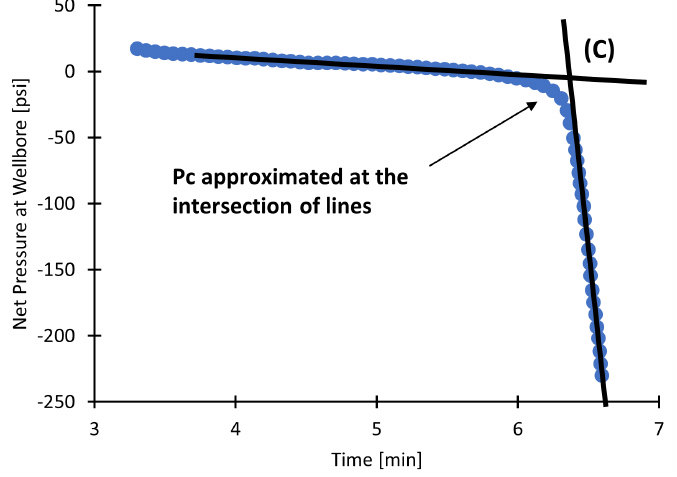
Figure 6. Closure pressure at intersection of double lines [31].